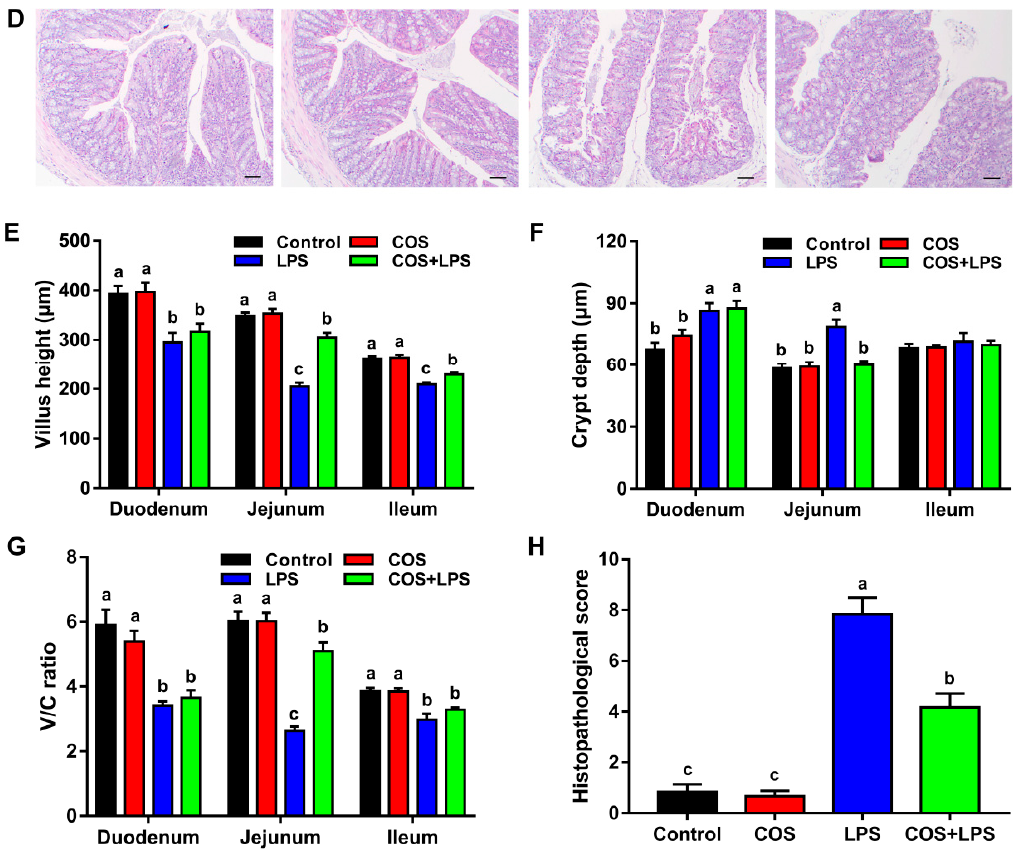
Figure 2. Effects of COS on the intestinal morphology in mice. Representative images of the duodenum ( A ), jejunum ( B ), ileum ( C ) and colon ( D ) stained with hematoxylin-eosin, scale bar = 30 µ m. The villus height ( E ), crypt depth ( F ) and ratio of villus height to crypt depth ( G ) of the duodenum, jejunum and ileum. ( H ) The histopathological score of colon. The data are presented as the mean ± SE ( n = 6). Values without a common letter are significantly different ( p < 0.05). COS, chitosan oligosaccharide; LPS, Lipopolysaccharide; and V/C, villus height/crypt